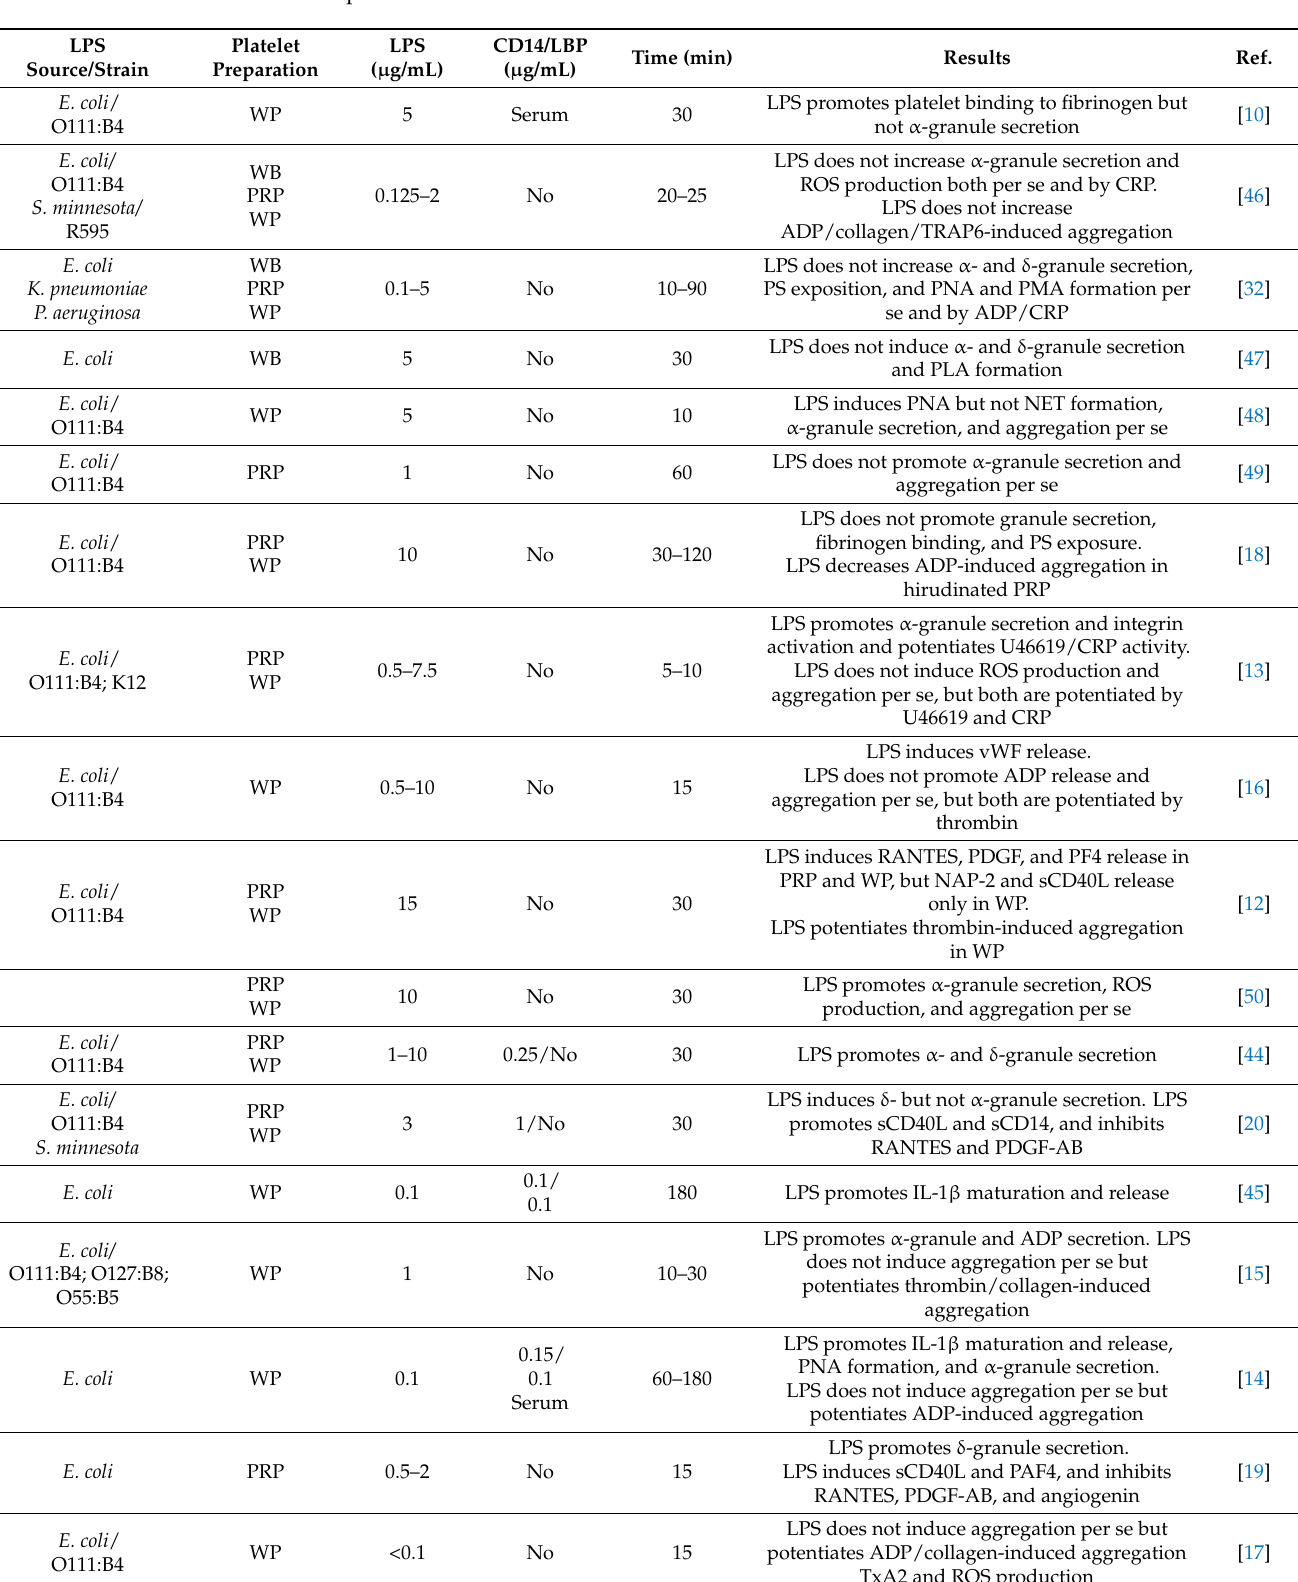
Table 1. Materials, methods, and results in LPS-induced platelet activation experiments. In the table are summarized the main results and the main different experimental conditions among the studies: LPS sources/strains, platelet preparation, LPS and CD14/LBP concentrations, and time of stimulation of